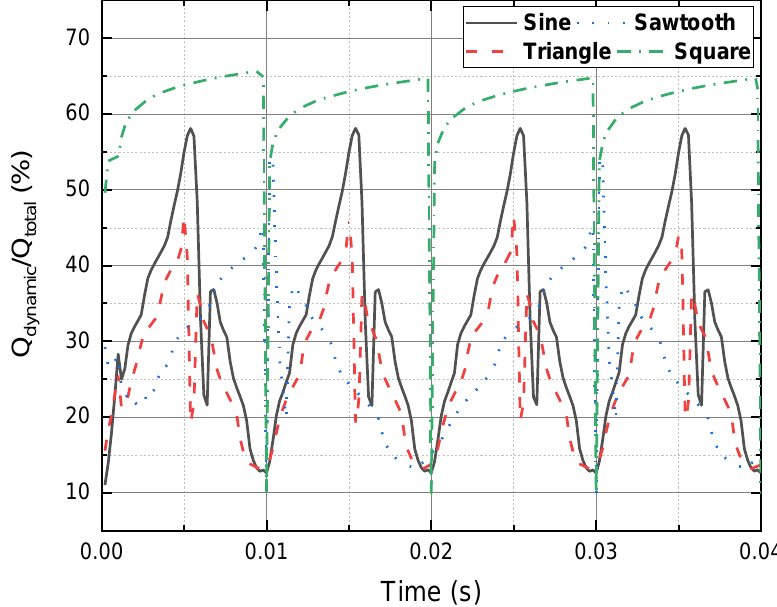
Figure 10. Ratios of Q dynamic / Q total of a 4 mm HTS tape, carrying a 30 A DC transport current and in the presence of four different perpendicular AC magnetic fields (sinusoidal, triangle, sawtooth and square) at 50 Hz, with the peak magnitude 90 mT.